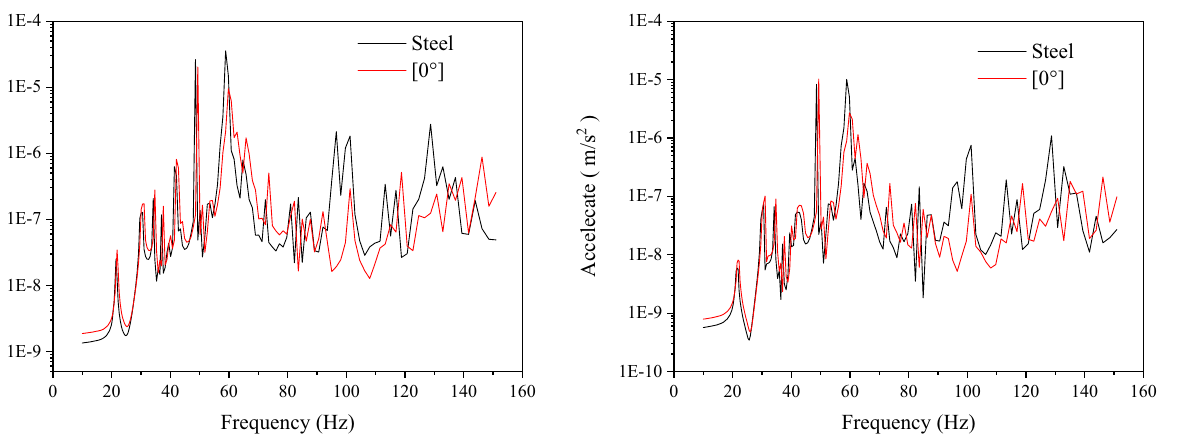
Figure 6: Comparison of acceleration response at the maximum response point of composite and steel fl oating rafts.